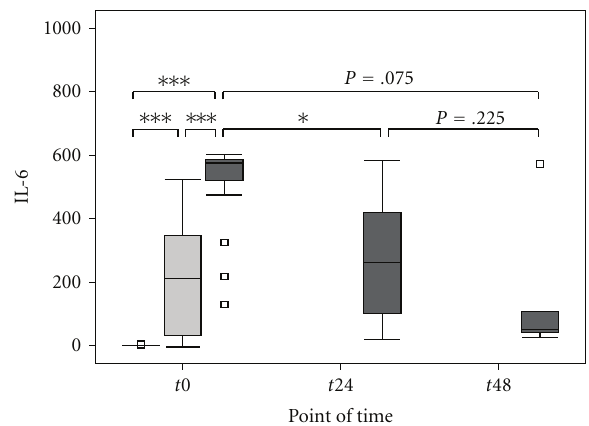
Figure 1: Comparison of Interleukin-6 (IL-6) in the volunteer, postoperative, and septic groups at baseline and at 24 and 48 hours in the septic group. Concentrations of Interleukin-6 (IL-6; (pg/ml)) were measured from the sera of healthy volunteers (“Healthy”, n = 18, white box), postoperative patients after major abdominal surgery (“Post-OP”, n = 28, light grey box), and patients with sepsis (“Sepsis”, n = 15, dark grey box), at t 0 (measured once for the volunteer group, immediately after surgery for the postoperative group, and at the time of diagnosis of sepsis for the sepsis group). In addition, for the septic group, the 2 other times of data collection are represented, t 24 and t 48 for 24 and 48 hours, respectively, after the diagnosis of sepsis. Data in box plots are given as median, 25th percentile, 75th percentile, and the 1.5 interquartile range. Outliers are shown in form of circles (1.5–3 interquartile ranges above 75th percentile or below 25th percentile) or rectangles ( > 3 interquartile ranges above 75th percentile or below 25th